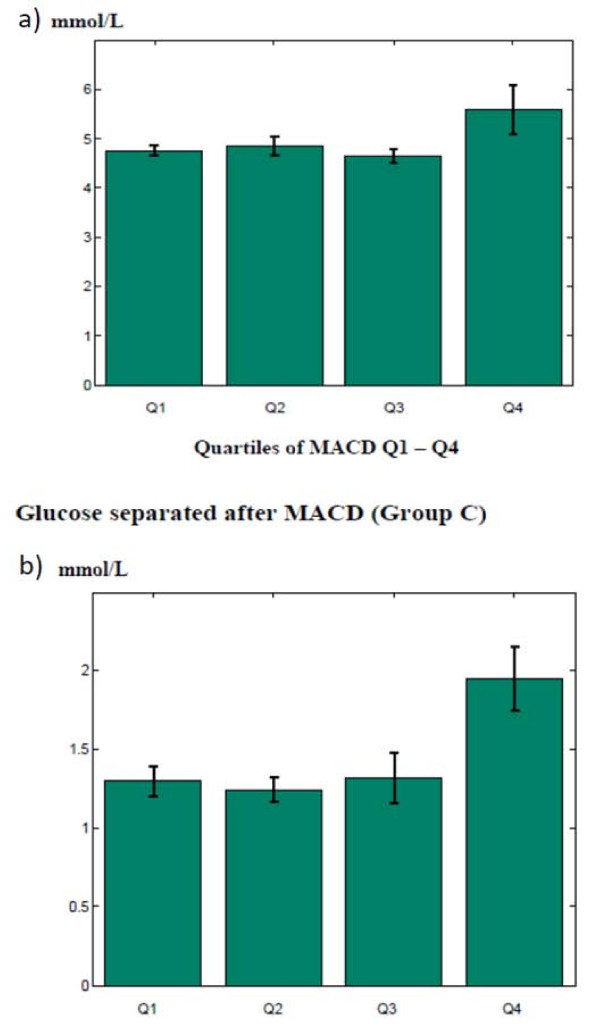
Glucose level (a) and triglyceride level (b) for the baseline-calcified population in quartiles according to MACD.